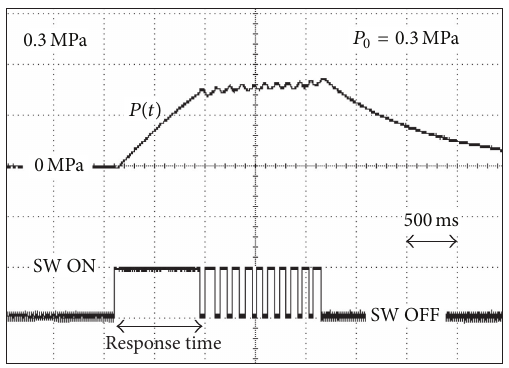
Figure 12: PWM control of the solenoid valve.